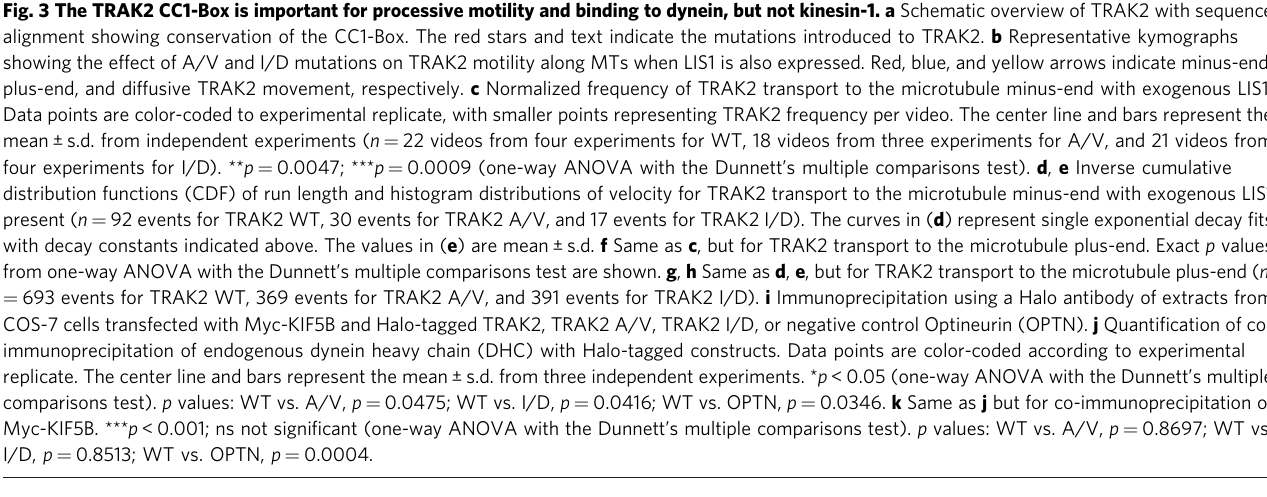
Fig. 3 The TRAK2 CC1-Box is important for processive motility and binding to dynein, but not kinesin-1. a Schematic overview of TRAK2 with sequence alignment showing conservation of the CC1-Box. The red stars and text indicate the mutations introduced to TRAK2. b Representative kymographs showing the effect of A/V and I/D mutations on TRAK2 motility along MTs when LIS1 is also expressed. Red, blue, and yellow arrows indicate minus-end, plus-end, and diffusive TRAK2 movement, respectively. c Normalized frequency of TRAK2 transport to the microtubule minus-end with exogenous LIS1. Data points are color-coded to experimental replicate, with smaller points representing TRAK2 frequency per video. The center line and bars represent the mean ± s.d. from independent experiments ( n = 22 videos from four experiments for WT, 18 videos from three experiments for A/V, and 21 videos from four experiments for I/D). ** p = 0.0047; *** p = 0.0009 (one-way ANOVA with the Dunnett ’ s multiple comparisons test). d , e Inverse cumulative distribution functions (CDF) of run length and histogram distributions of velocity for TRAK2 transport to the microtubule minus-end with exogenous LIS1 present ( n = 92 events for TRAK2 WT, 30 events for TRAK2 A/V, and 17 events for TRAK2 I/D). The curves in ( d ) represent single exponential decay fi ts with decay constants indicated above. The values in ( e ) are mean ± s.d. f Same as c , but for TRAK2 transport to the microtubule plus-end. Exact p values from one-way ANOVA with the Dunnett ’ s multiple comparisons test are shown. g , h Same as d , e , but for TRAK2 transport to the microtubule plus-end ( n = 693 events for TRAK2 WT, 369 events for TRAK2 A/V, and 391 events for TRAK2 I/D). i Immunoprecipitation using a Halo antibody of extracts from COS-7 cells transfected with Myc-KIF5B and Halo-tagged TRAK2, TRAK2 A/V, TRAK2 I/D, or negative control Optineurin (OPTN). j Quanti fi cation of co- immunoprecipitation of endogenous dynein heavy chain (DHC) with Halo-tagged constructs. Data points are color-coded according to experimental replicate. The center line and bars represent the mean ± s.d. from three independent experiments. * p < 0.05 (one-way ANOVA with the Dunnett ’ s multiple comparisons test). p values: WT vs. A/V, p = 0.0475; WT vs. I/D, p = 0.0416; WT vs. OPTN, p = 0.0346. k Same as j but for co-immunoprecipitation of Myc-KIF5B. *** p < 0.001; ns not signi fi cant (one-way ANOVA with the Dunnett ’ s multiple comparisons test). p values: WT vs. A/V, p = 0.8697; WT